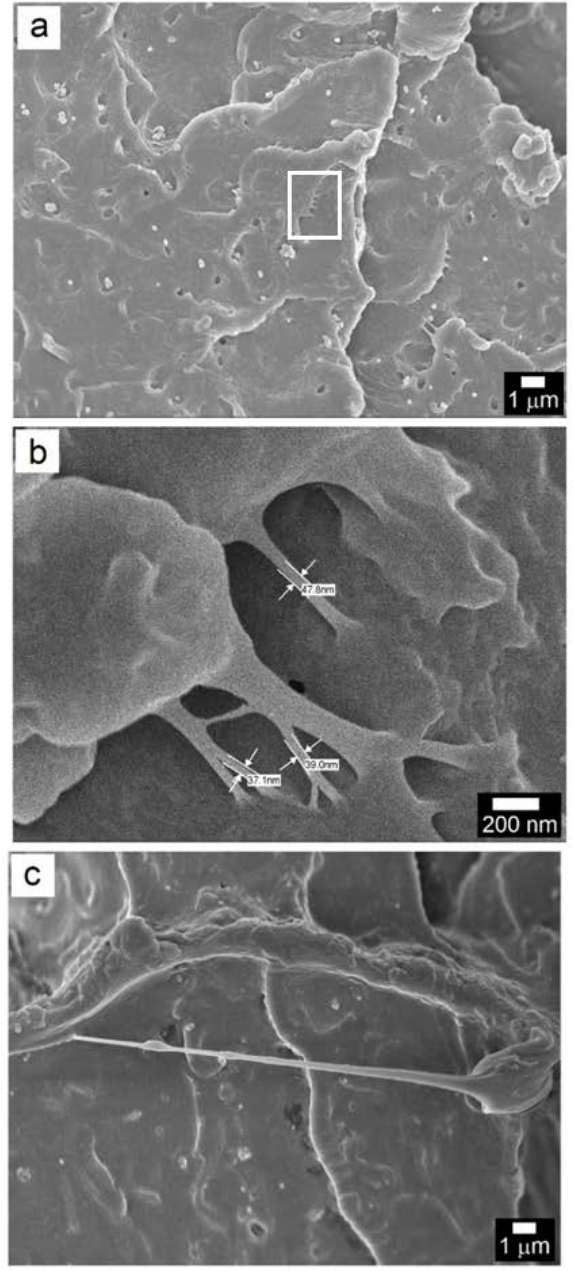
Figure 13. PC/TiO 2 -0.05HN cross-section after liquid nitrogen fracture of the notched composite: ( a , b ) Low and high magnification micrographs, and ( c ) region representing gradual thinning of bridge formed by TiO 2 nanosheets and nanotubes between polycarbonate segments.